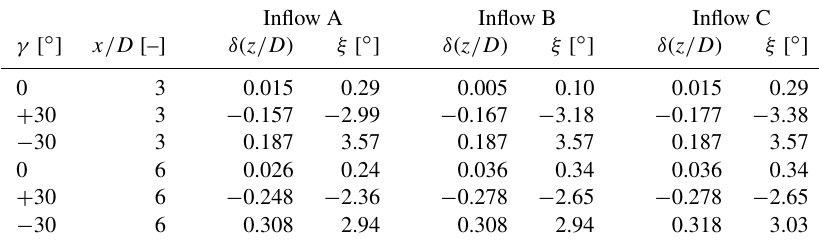
Table 3. Lateral deflection δ ( z/D ) [–] and wake skew angle ξ [ ◦ ] calculated with the available-power method. Inflow A Inflow B Inflow C